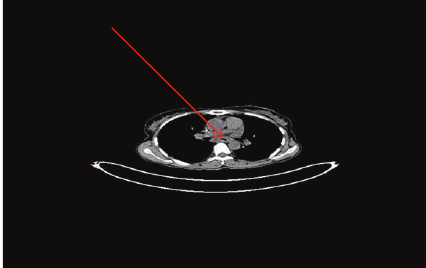
Figure 3: After neoadjuvant therapy, control CT of regressed mass (arrow).